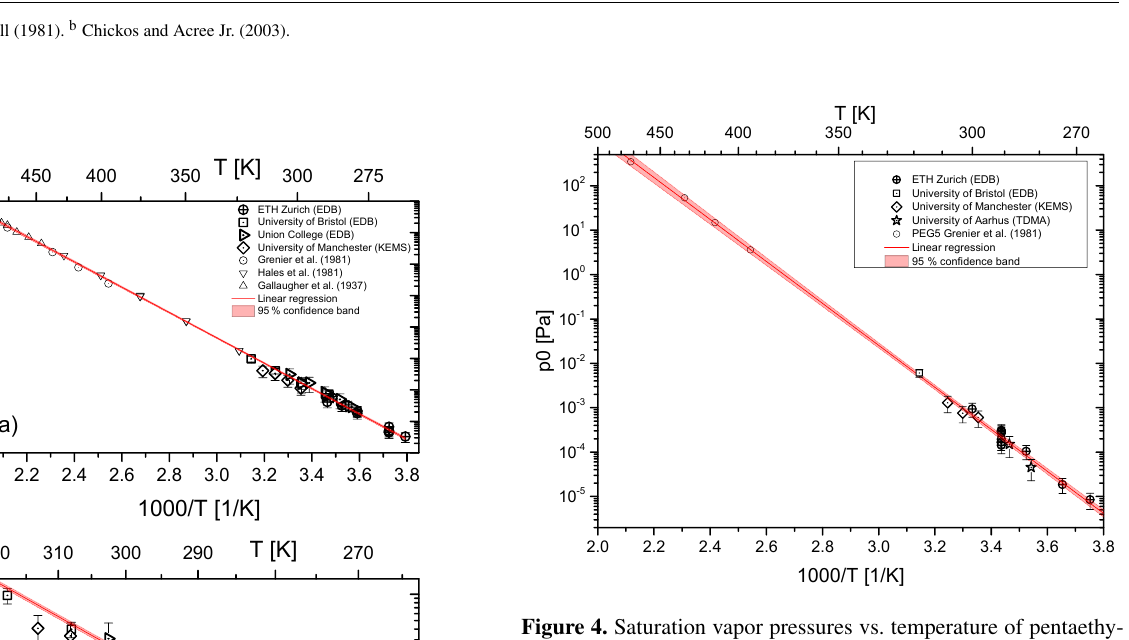
Tetraethylene glycol was measured with the three EDB ments cover a temperature range from 263 to 318 K; together the complete data set covers a range from 263 to 482